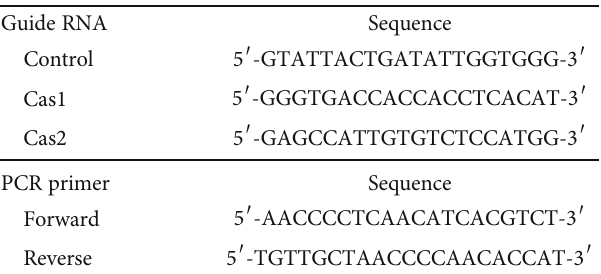
Table 3: Guide RNA and detection PCR primer sequence for B7-H6 knockout with